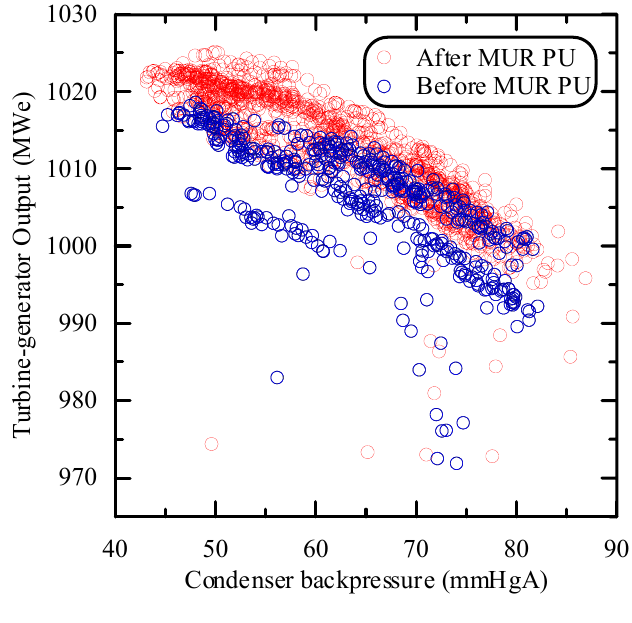
Figure 8. Turbine-generator output versus condenser backpressure.